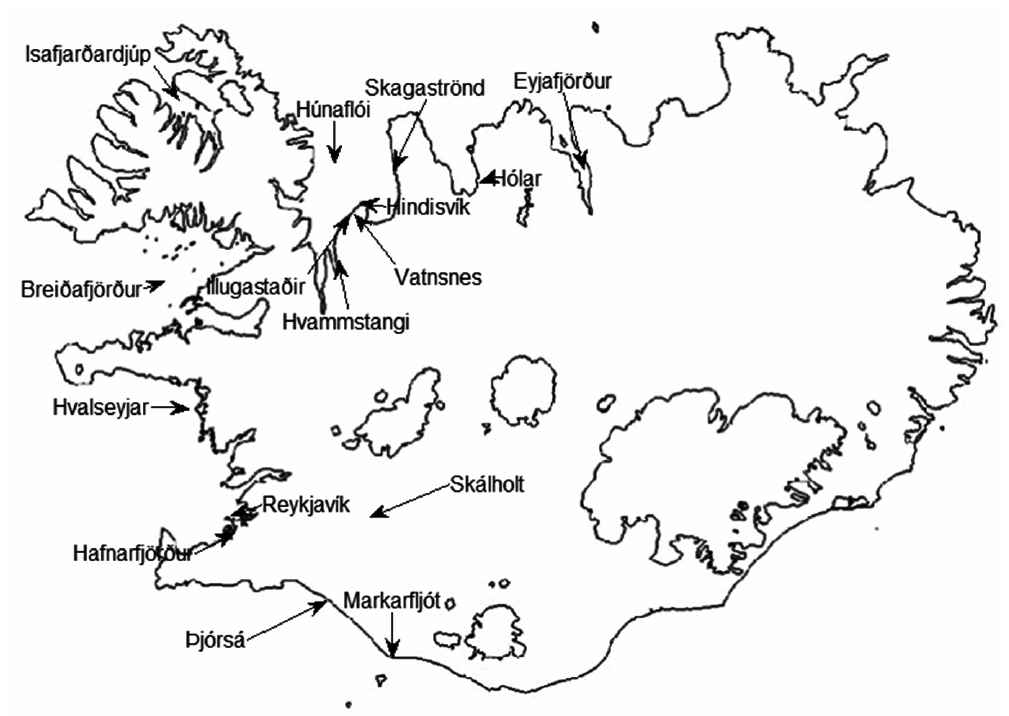
Fig. 2. Map of Iceland with locations and names of places referred to in the